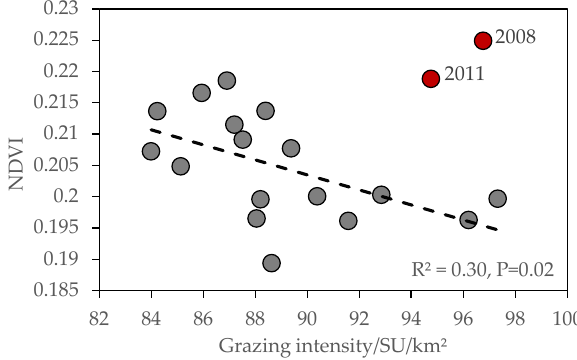
Figure 9. Relationship between NDVI and grazing intensity in Dinggye County.